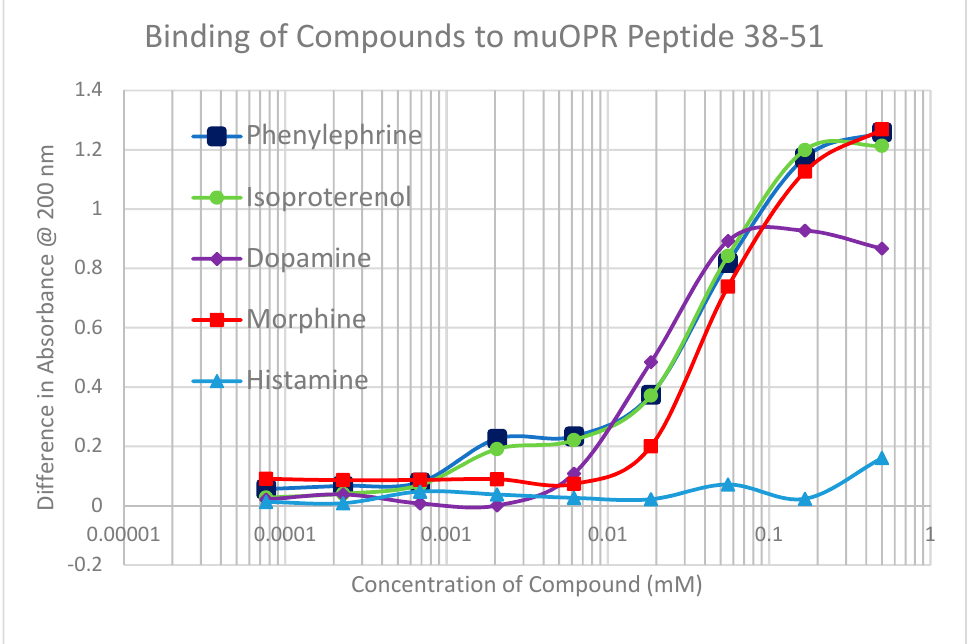
Figure 5. Binding of dopamine to mu opioid receptor (muOPR) peptides. Note that there is no high affinity binding evident as was observed with amphetamine (Figure 4). Dopamine displays only the lower affinity binding at around 70 μ M to 90 μ M. As with amphetamine (Figure 4), no measurable binding was observed between dopamine and the transmembrane peptide Mu 121.